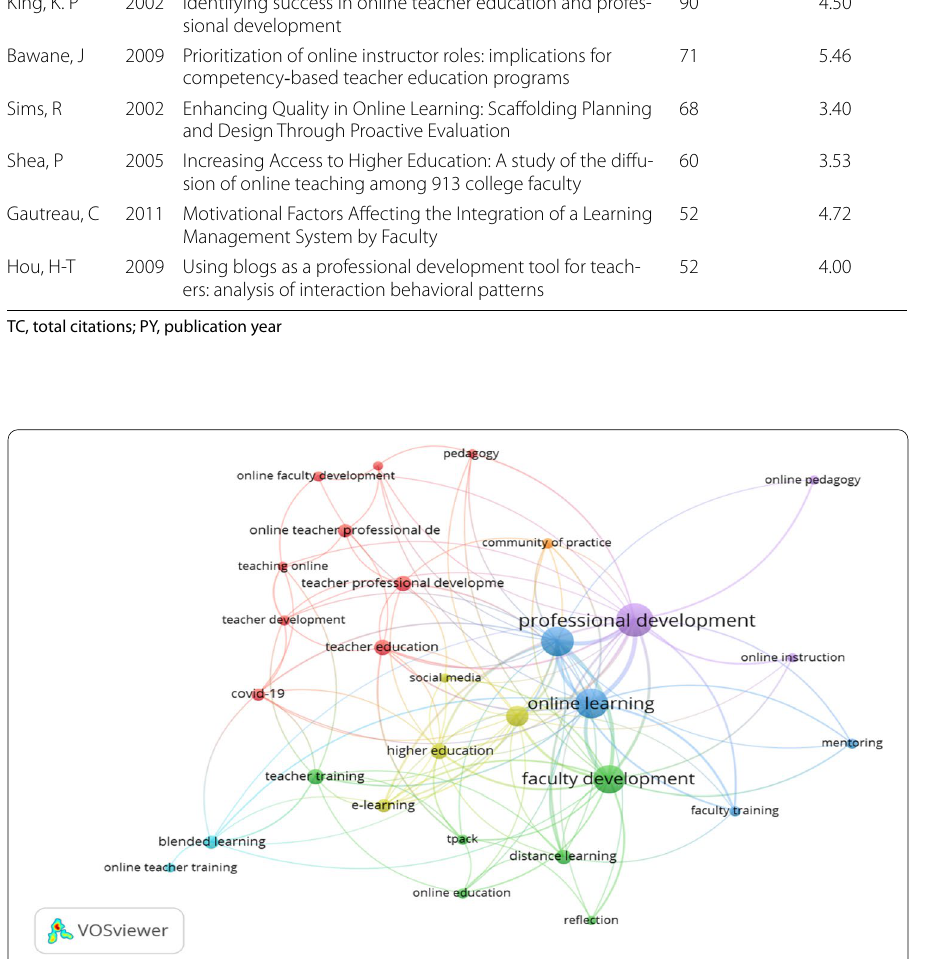
Fig. 5 Co-occurrence network of author